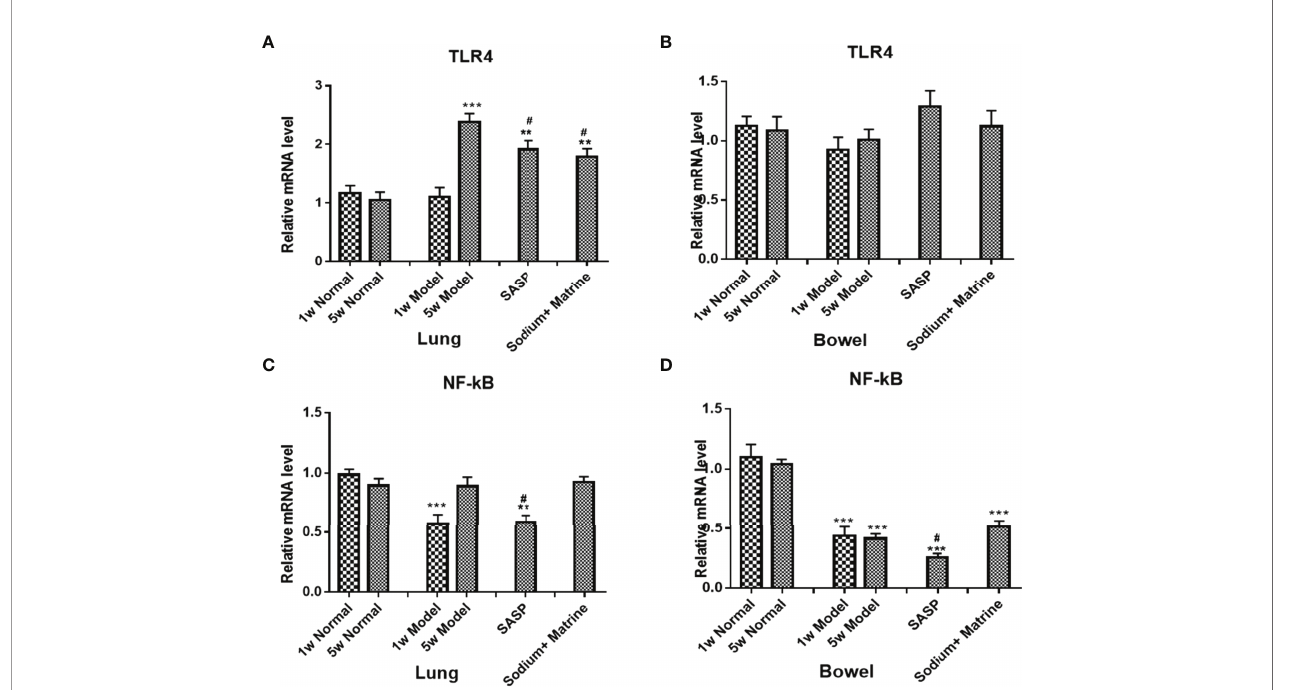
FIGURE 2 | Expression of TLR4 mRNA, NF-kB mRNA, and MIF mRNA in the lung and bowel. UC models were established with the mucous membrane of colon allergize combined with TNBS-alcohol enteroclysis. TLR4 mRNA in Lung (A) and Bowel (B) ; NF-kB mRNA in Lung (C) and Bowel (D) . Compared with Normal group, **P < 0.01; ***P < 0.001. Compared with model group, # P <